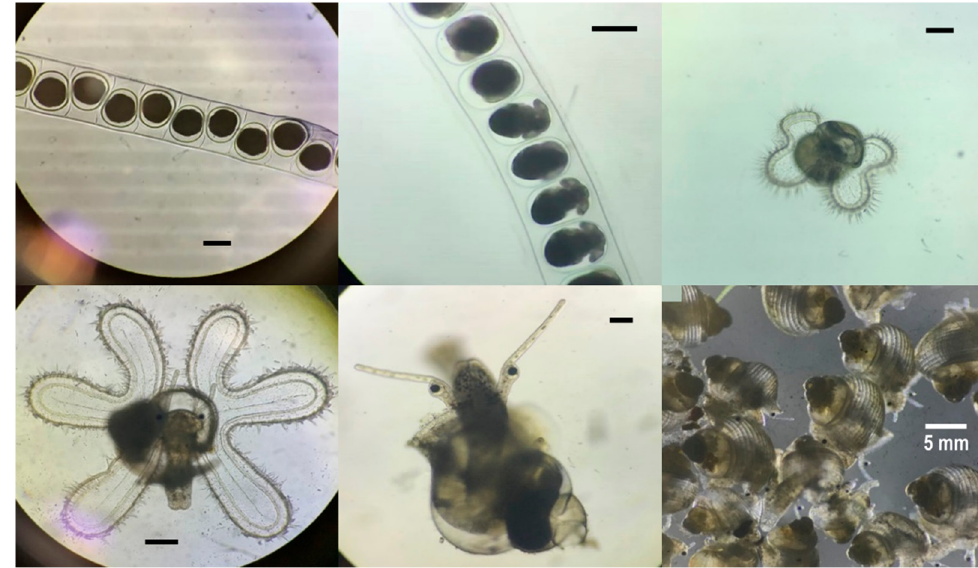
Figure 1. The development stages of Laevistrombus canarium . Egg capsules ( top left ); embryo ( top center ); 4-lobed veliger (top right); 6-lobed veliger (bottom left); newly metamorphosed juveniles (bottom center) (Scale bar = 100 μ m); 10 mm juveniles (bottom right) (Scale bar = 5 mm).